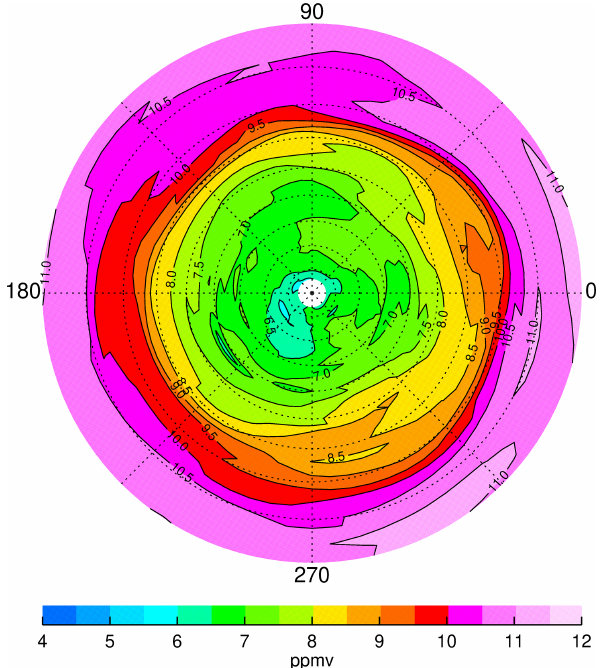
Figure 10. V6 ozone at 10hPa for 15 March 1979 in the NH. Ozone contour interval is 0.5ppmv, and latitude spacing (dotted circles) is 10 ◦